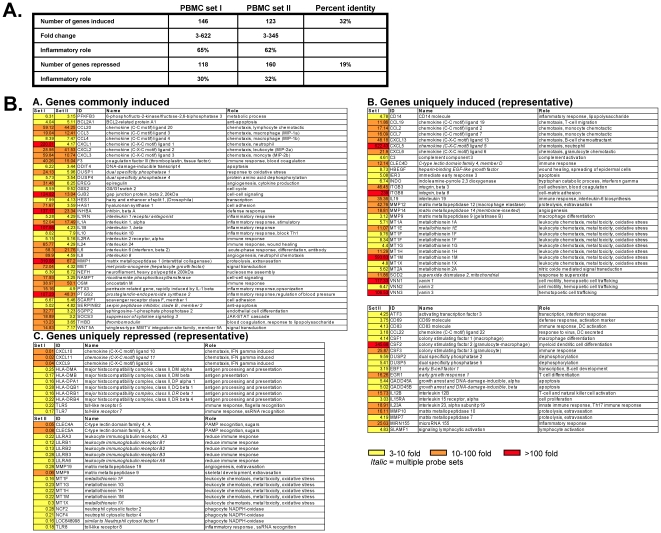
Different PBMC isolates led to similar changes in gene expression following treatment with Astragalus membranaceus.
Commercially available (PBMC set I) or fresh PBMCs (PBMC set II) were treated with Astragalus extract for 18 hours. Genes were sorted based on a threefold (P<0.01) or greater level of induction or repression relative to ethanol-treatment. Part A represents the overall comparison of genes regulated between PBMC set I and PBMC set II. For Part B, specific immune/inflammatory genes commonly or uniquely altered in expression following Astragalus treatment of PBMC set I and PBMC set II are shown. Changes (n-fold) in expression level relative to those of ethanol-treated cells are shown within each box. Red boxes represent genes induced 100-fold or higher, orange boxes represent genes induced 10-100-fold, and yellow boxes represent genes induced 3-10-fold.